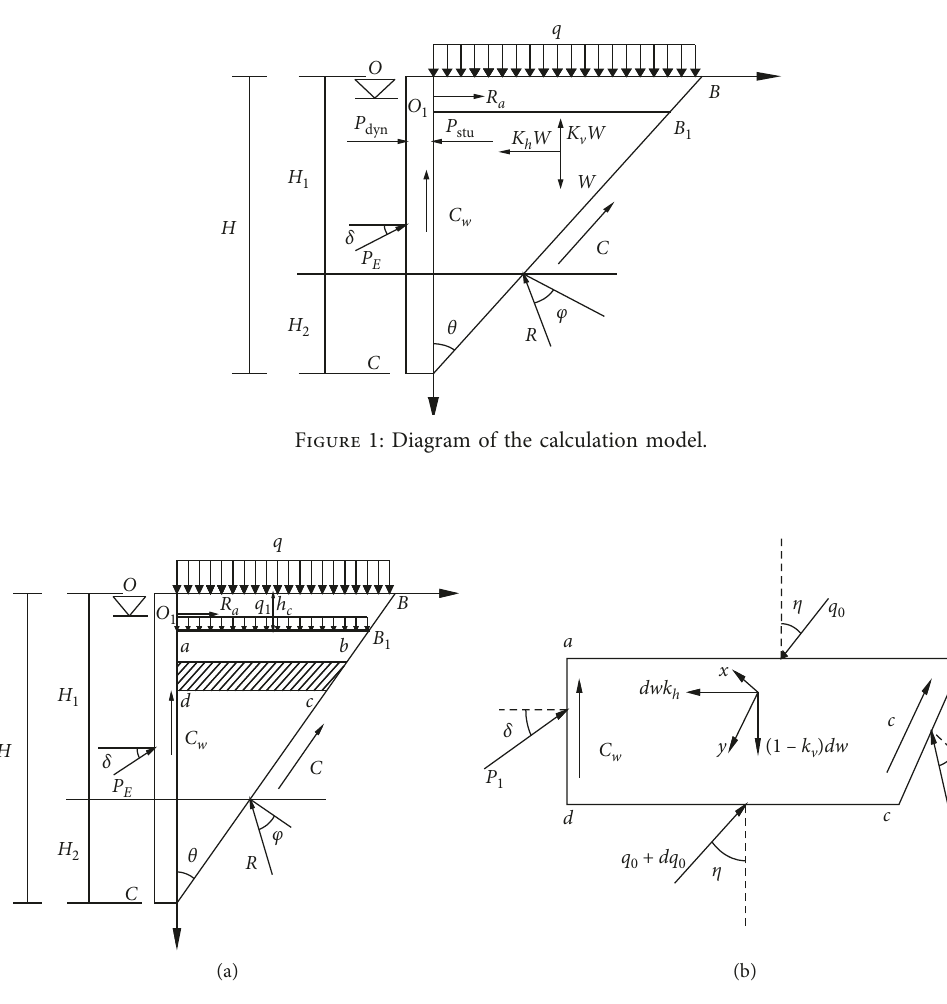
Figure 2: (a) Schematic diagram of seismic total active earth pressure. (b) Forces acting on a horizontal microelement soil mass.